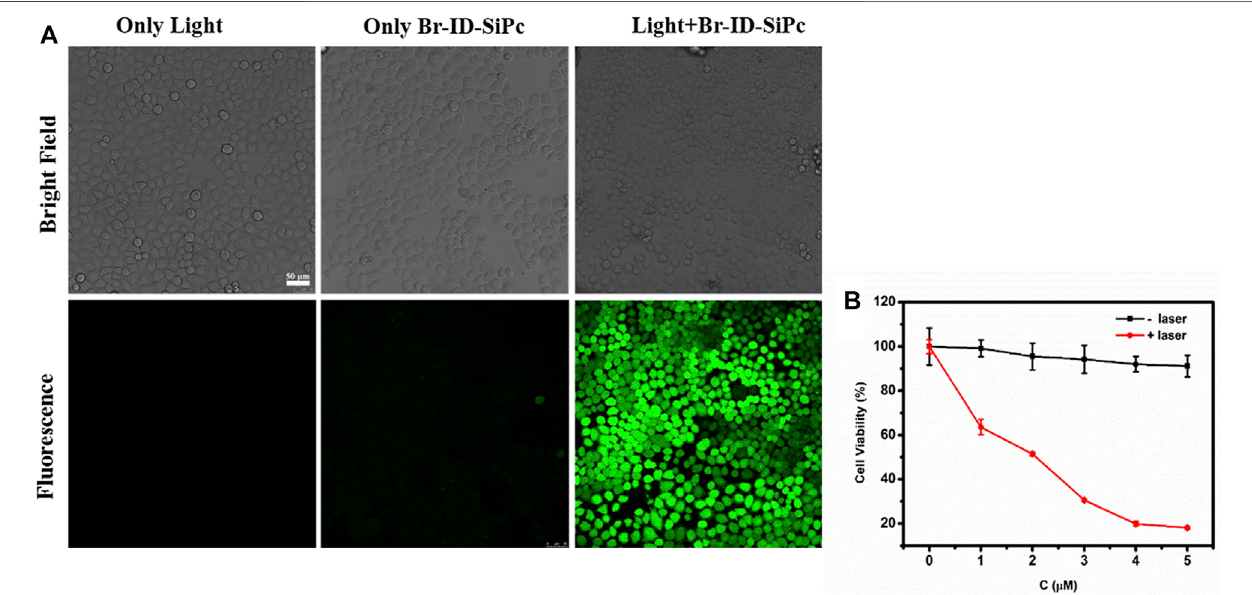
FIGURE5| ROSgenerationinHO-8910cellswasdetectedbyconfocalmicroscopy fl uorescenceimagingusingCM-H2DCFDA fl uorescentprobe( C CM-H2DCFDA = 10 μ M; λ ex = 488 nm, λ em = 490 – 590 nm) (A) ; Viability of HO-8910 cell treated by Br-ID-SiPc in the absence or presence of light (B) .